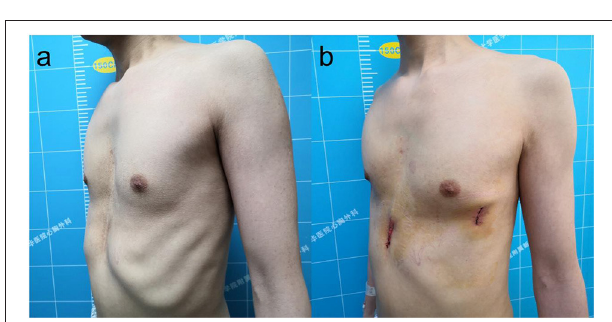
FIGURE 1 | Bar configuration and accessories. (A) One end of the titanium alloy bar was fused with a bar stabilizer. (B) Introducer of bar. (C) Bar stabilizer. (D) Bar connect with introducer. (E) Bar connect with stabilizer. (F) Different sizes of bars.